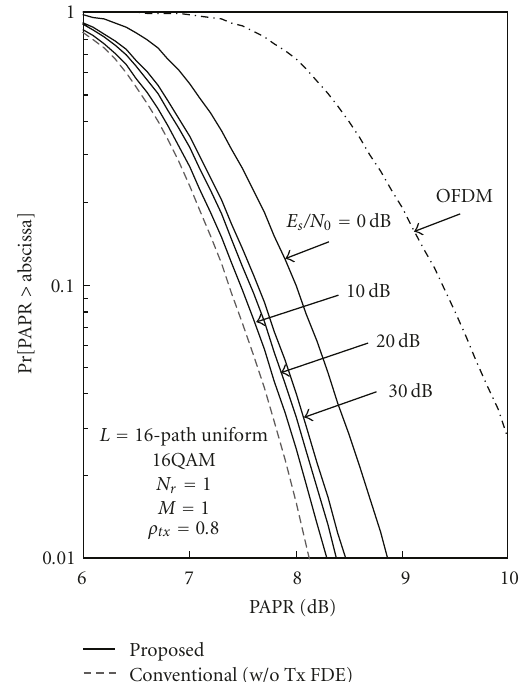
Figure 11: PAPR distribution with m as a parameter for M = 4.